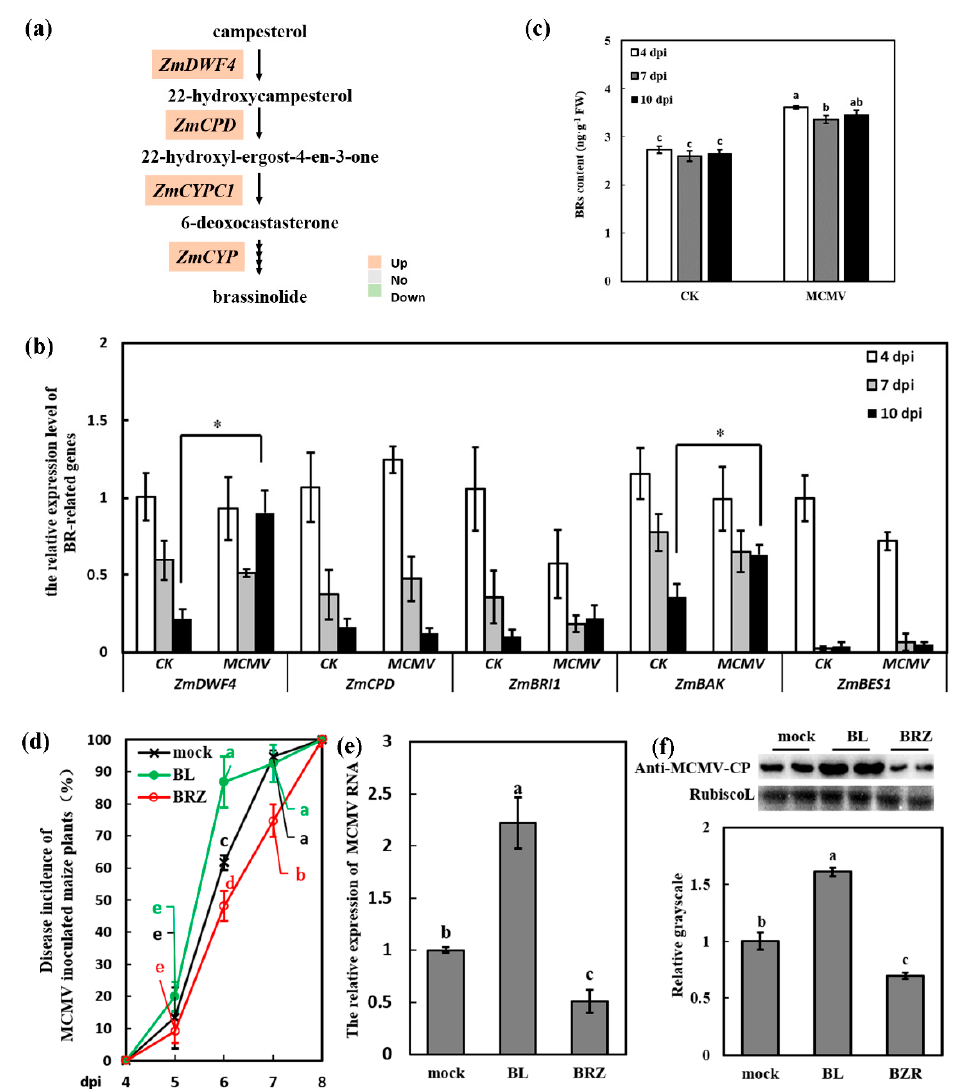
Figure 3. Brassinosteroid (BR) induced the susceptibility of maize to MCMV infection. ( a ) Transcriptional changes of BR biosynthesis pathway-associated genes during MCMV infection in maize. Highlighted in orange are up-regulated, while highlighted in green are down-regulated in the RNA-seq dataset. ( b ) RT-qPCR verification of the expression of BR pathway-related genes in response to MCMV infection at 4, 7, and 10 dpi in maize. ( c ) Endogenous BR concentration in the SL1 at 4, 7, 10 dpi in maize. ( d ) Disease incidence (%) of maize plants post MCMV inoculation with application of Tween-20 (0.02%, mock), 2,4-epibrassinolide (BL) (500 µ M), and brassinazole (BRZ) (1 µ M). Significant differences of disease incidence (%) between different treatments (mock, BL and BRZ) in the same dpi were indicated in lowercase letters ( e ) RT-qPCR analysis of the MCMV RNA accumulation after application of Tween-20 (0.02%, mock), BL (500 µ M), and BRZ (1 µ M). ( f ) Representative western blot showing MCMV accumulation with application of Tween-20 (0.02%, mock), BL (500 µ M), and BRZ (1 µ M). The grayscales of immunoblotting bands were determined by ImageJ. Graphs represent quantifications from three independent experiments with at least 3 plants per experiment. Statistical analysis was conducted using SPSS 16.0 followed by ANOVA with LSD test at the level of p -value ≤ 0.05. Significant difference between different samples was indicated in lowercase letters or